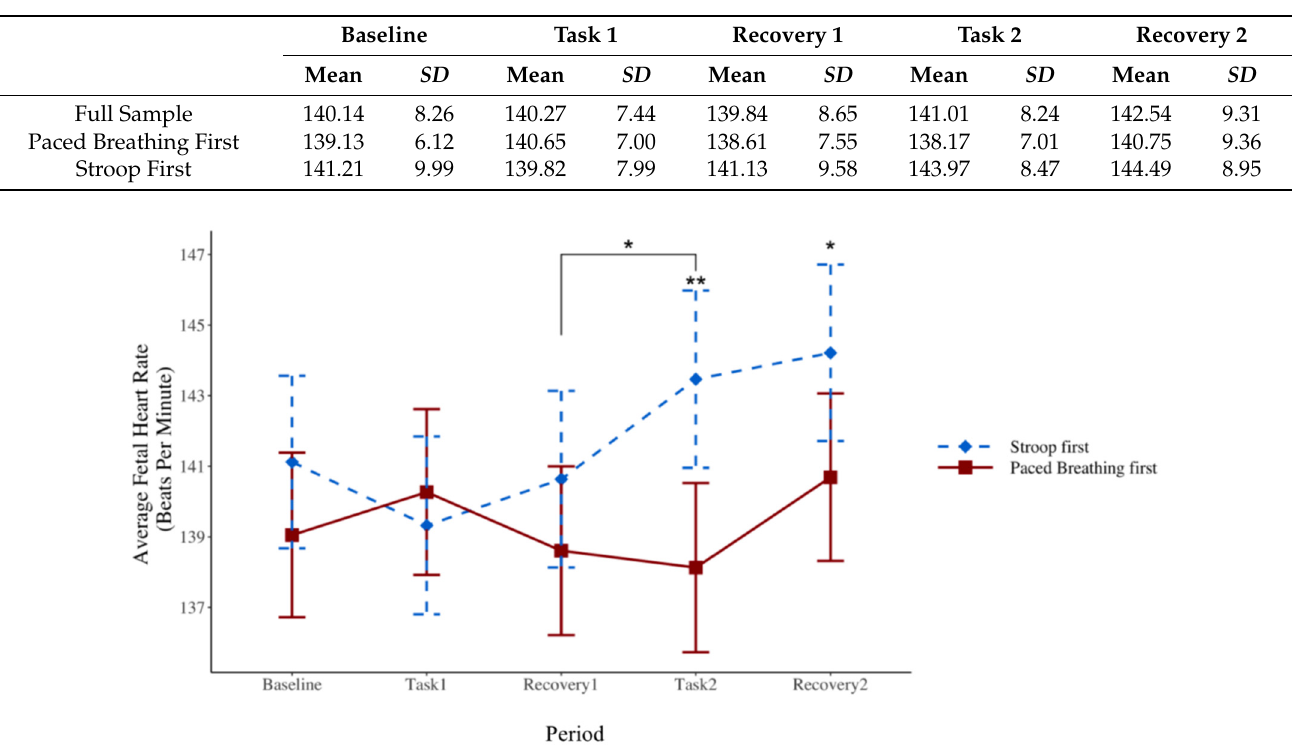
Figure 3. Fetal HR During Each Study Period By Group. * p < 0.05, ** p < 0.01